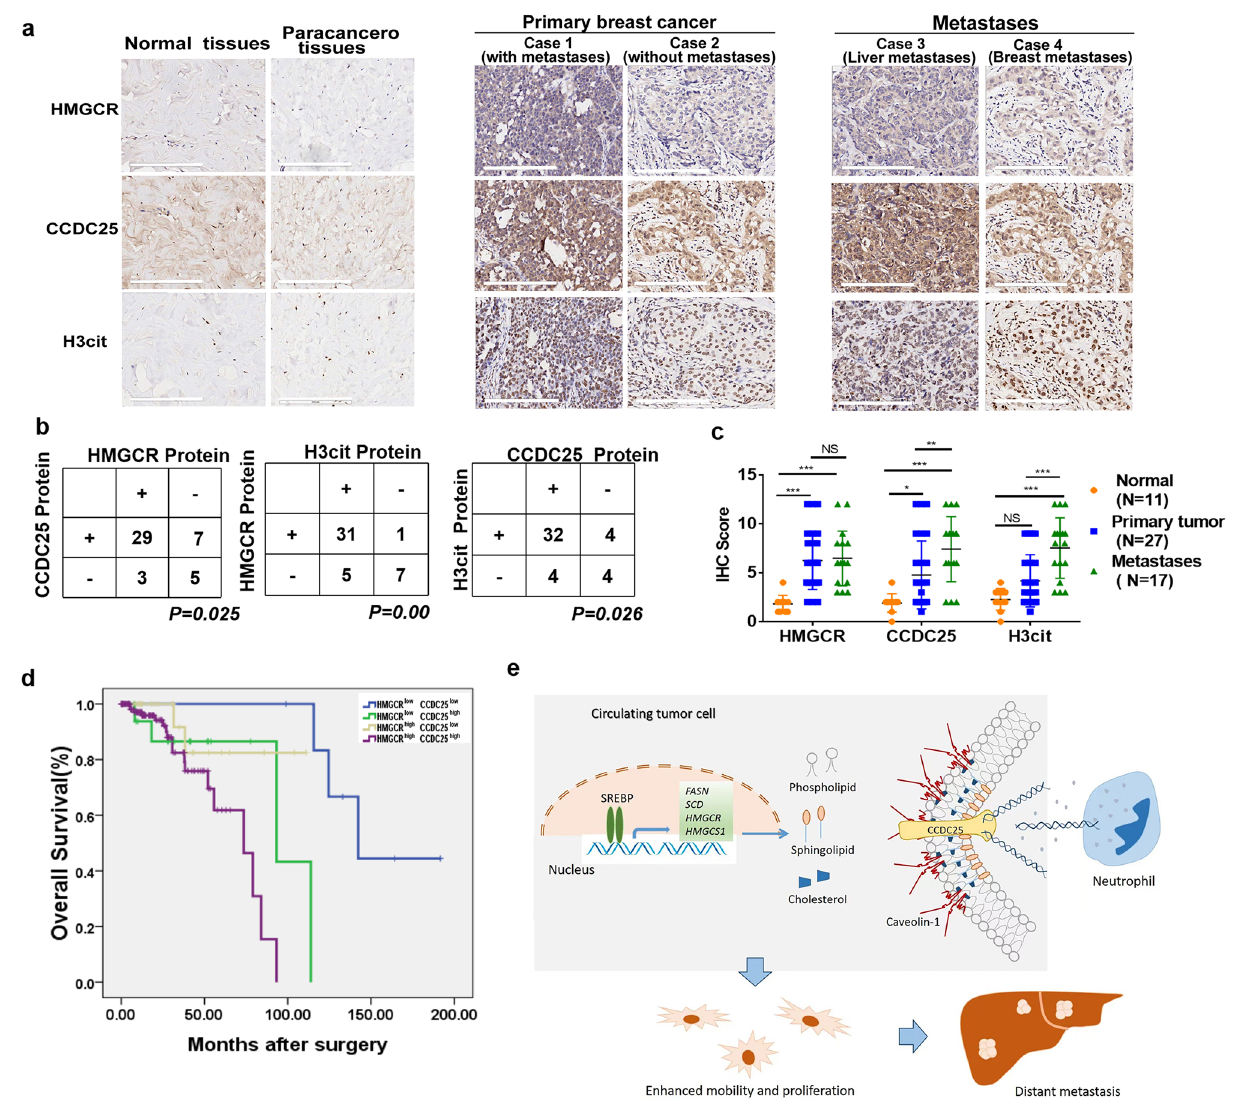
Figure 8. Tissue microarray staining and statistical analysis. ( a ) CCDC25, H3cit and HMGCR were detected by immunohistochemical staining in a tissue microarray containing 60 breast tissues. Representative pictures of IHC staining in normal or papacancerous breast tissues, primary breast cancer tissues, and metastatic tissues. Scale bars: 200 µm. ( b ) Statistical analyses of the correlations between HMGCR and CCDC25, HMGCR and H3cit, CCDC25 and H3cit, according to immunohistochemical scoring by Fisher’s test. ( c ) Statistical analyses IHC score of HMGCR, CCDC25 and H3cit in normal tissues, primary breast cancer tissues and metastatic tissues by Two-way ANOVA test. ( d ) Kaplan–Meier curves showing the overall survival of patients with breast cancer with high or low CCDC25 and HMGCR expression in The Cancer Genome Atlas (TCGA) breast cancer online database (n = 176). Comparisons were performed using a log rank test. P < 0.05; ** P < 0.01; *** P < 0.001. ( e ) The schematic model depicts how cholesterol biosynthesis contributes to CCDC25 expression, NETs formation and distant